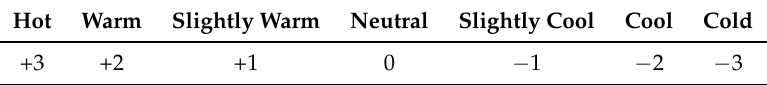
Table 1. ASHRAE thermal sensation